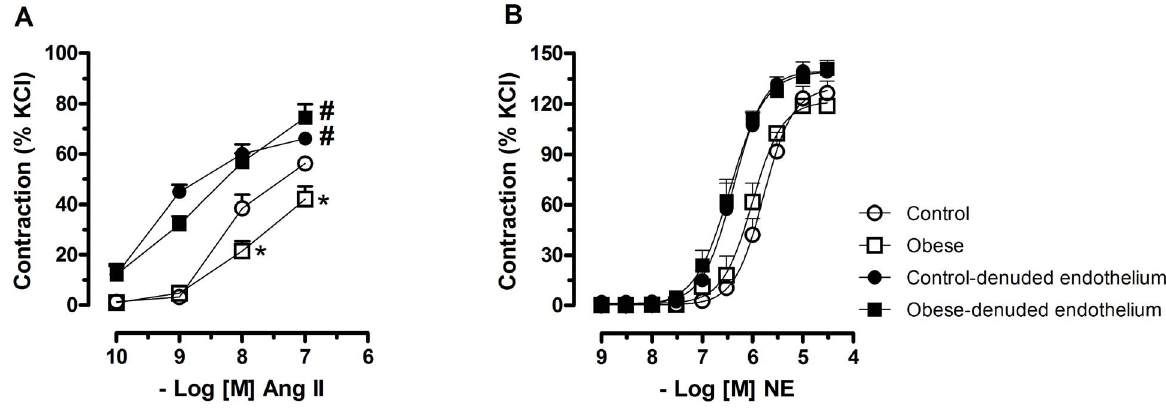
Figure 1. Effect of obesity on contraction of mesenteric arteries to angiotensin II and norepinephrine. A- Non-cumulative concentration–response curves to angiotensin II (ANG II) obtained in different segments of endothelium intact and endothelium denuded mesenteric arteries from control and monosodium glutamate (MSG)-induced obese rats. The curves were performed on a top of a submaximal tone (30 to 40% of the maximum response) induced by norepinephrine (NE). B - Cumulative concentration–response curves to NE in endothelium intact and endothelium denuded mesenteric arteries from control and monosodium glutamate-induced obese rats. Each point represents the mean 6 SEM. *, P , 0.05 vs. Control; # , P , 0.05 vs. respective group in the absence of endothelium.